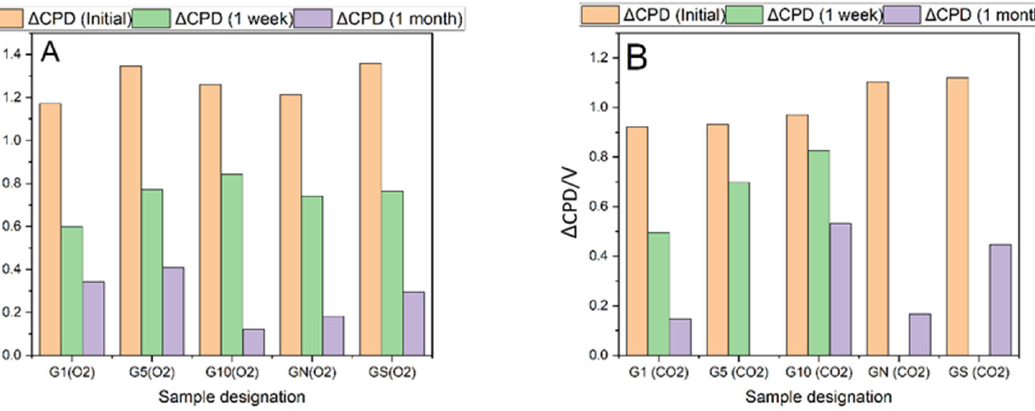
Figure 1. Work function changes after one week and one month after plasma treatment of of-the-shelf and acid-treated graphite samples. ( A ) oxygen plasma-G(O2), ( B ) CO 2 plasma-G(CO2). GN-nitric acid-washed graphite, GN(O2) and GN(CO2)-plasma-treated nitric acid-washed graphite, GS–sulfuric acid-washed graphite, GS(O2) and GS(CO2) plasma-treated sulfuric acid-washed graphite.